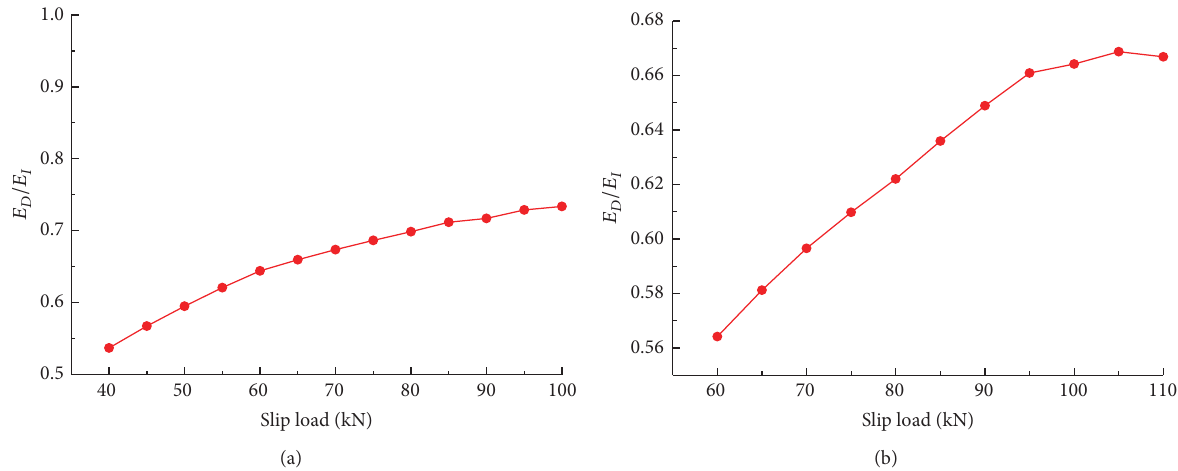
Figure 12: Energy dissipated by AFDs normalized by the input energy: (a) PGA = 0.4 g and (b) PGA = 0.62 g.